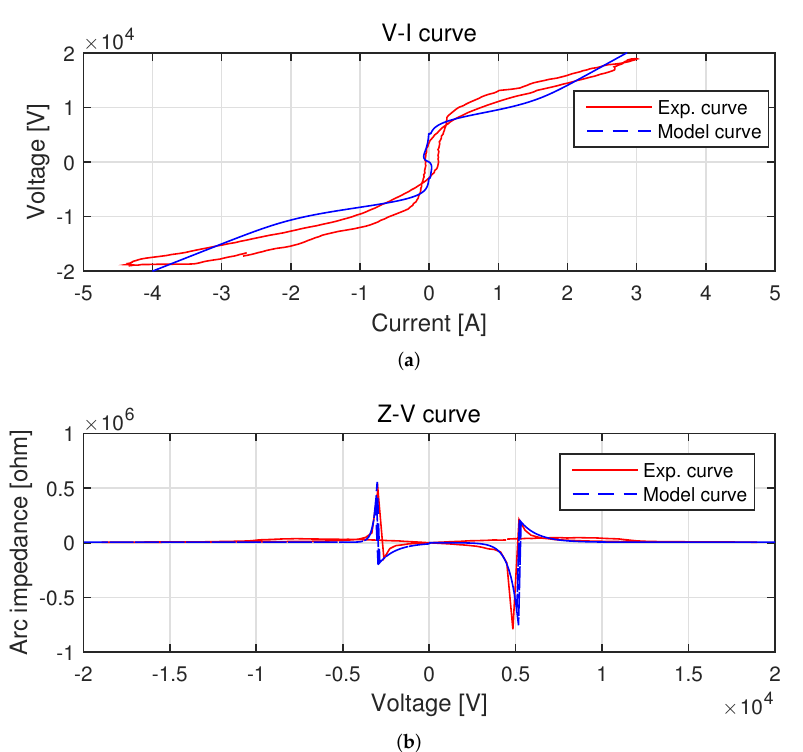
Figure 7. Comparison of simulated and experimental arc characteristics. ( a ) Voltage-current curves for both simulated and experimental arc models. ( b ) Impedance-voltage curves for both simulated and experimental arc